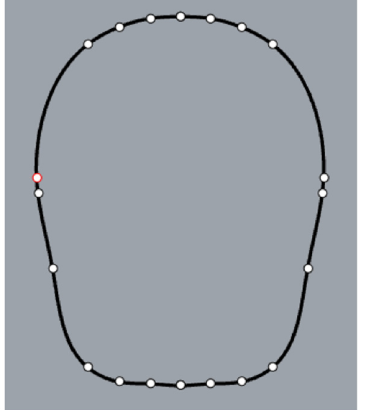
Fig. 7. Curve after interpolation.